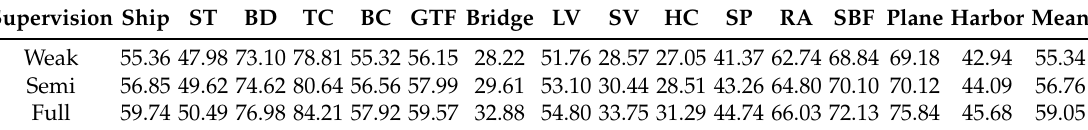
Table 6. Our segmentation results for per category on iSAID validation set, which are evaluated by mIoU (%). ST: Storage tank, BD: Baseball diamond, TC: Tennis court, BC: Basketball court, GTF: Ground field track, LV: Large vehicle, SV: Small vehicle, HC: Helicopter, SP: Swimmingpool, RA: Roundabout, SBF: